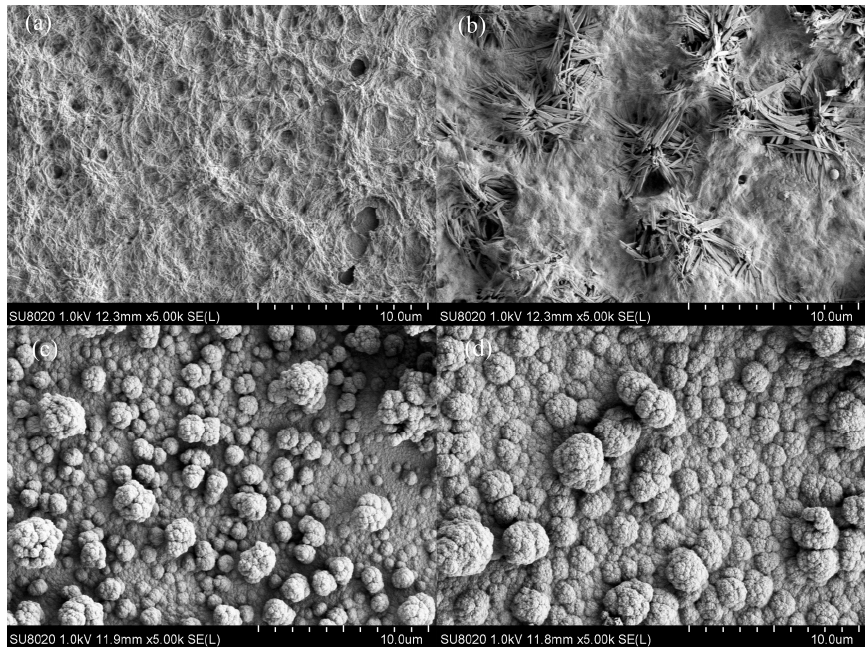
Figure 5. SEM images of the polymers with magnification of 5000: ( a ) P1; ( b ) P2; ( c ) P3; and ( d ) P4.